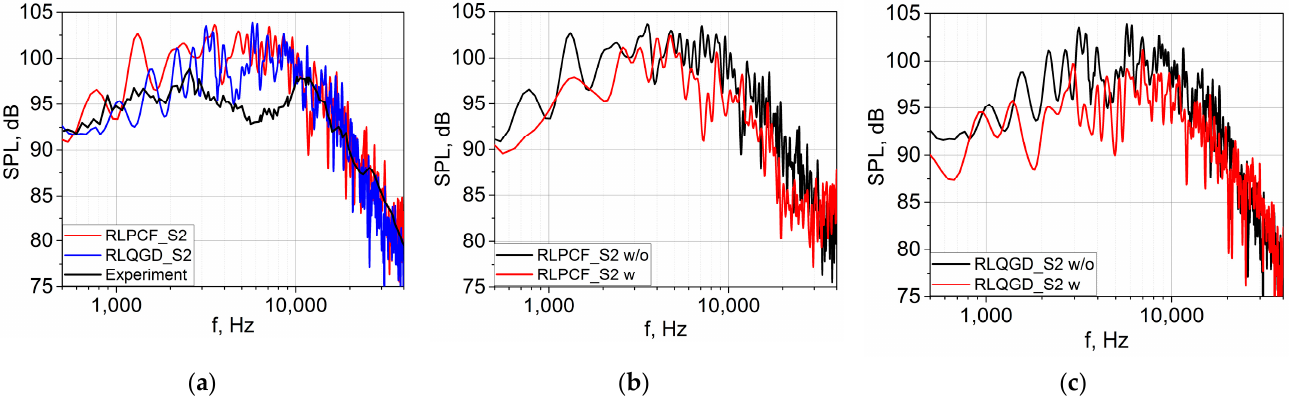
Figure 12. Narrowband frequency spectra at θ = 90°: ( a ) without water injection; ( b ) with the effect of water microjet injection calculated with the RLPCF solver; ( c ) with the effect of water microjet injection calculated with the RLQGD solver.